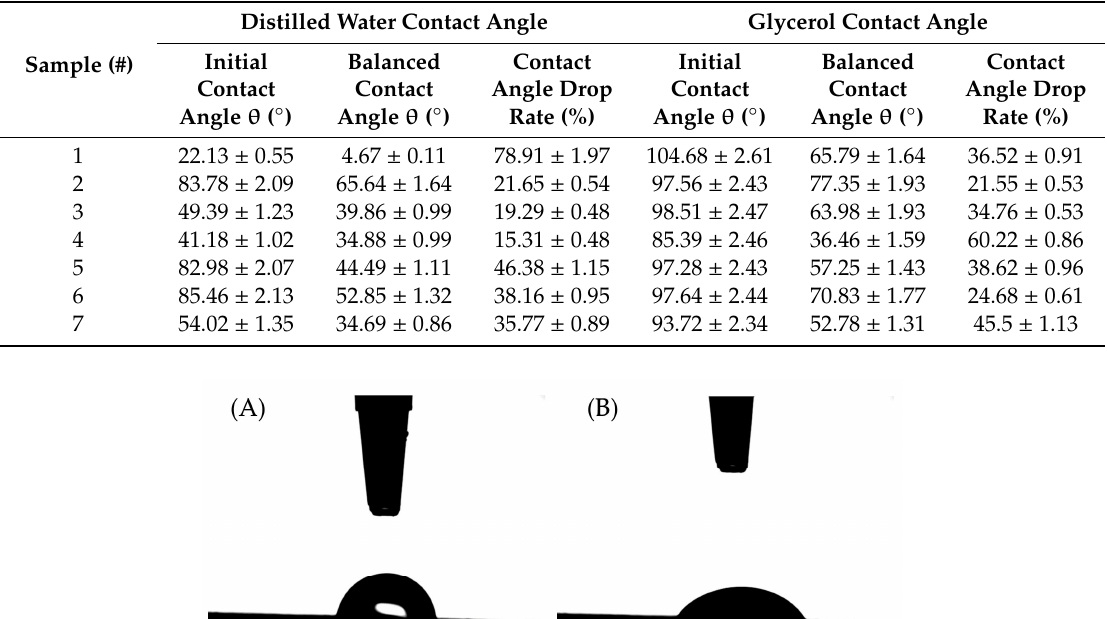
Table 3. Initial and equilibrium contact angles of distilled water and glycerin.